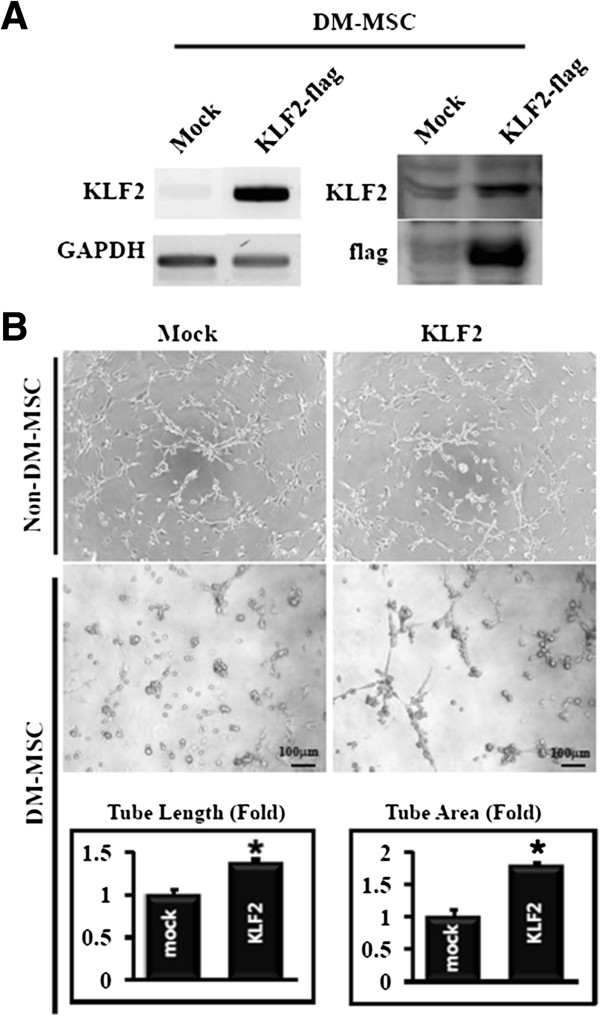
Enforced expression of KLF2 into DM-MSC recovered angiogenic activity (n=3). (A) Transfected KLF2 was measured by RT-PCR and Western blot against KLF2 and flag. (B) After transfection to non-DM-MSC or DM-MSC, tube formation was assessed and analyzed. *p < 0.05 vs mock-transfected DM-MSC.